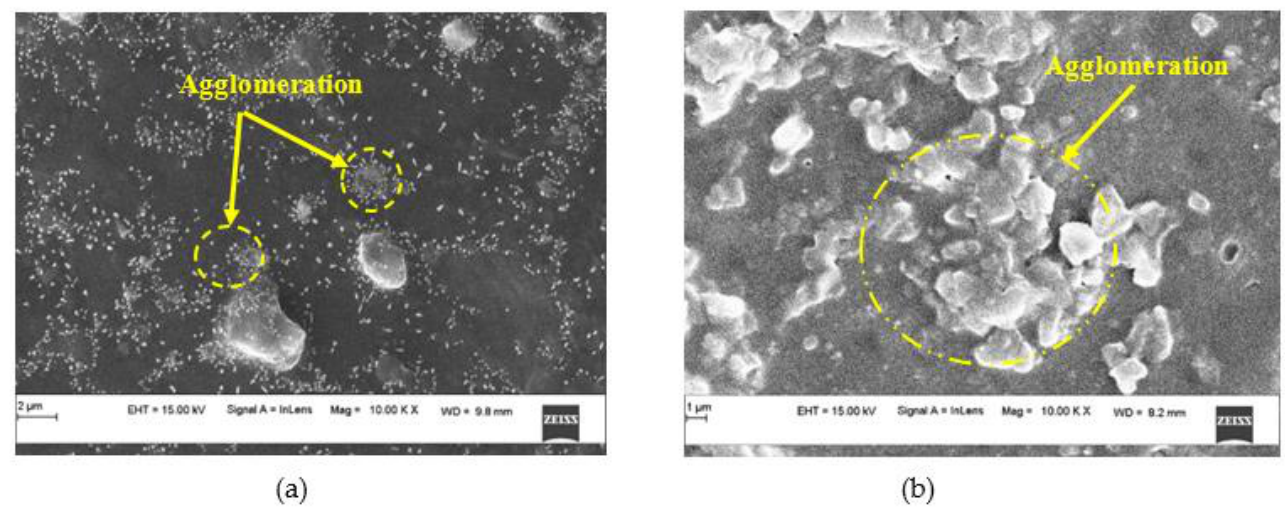
Figure 4. Agglomeration of nano-fillers: ( a ) 2 wt.% Al 2 O 3 ; ( b ) 2 wt.% SiC [50].